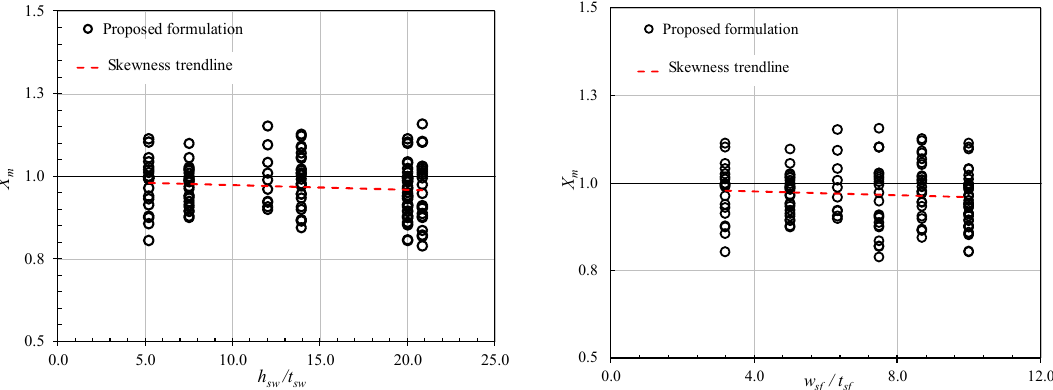
Figure 27. Skewness of the proposed formula against the basic parameters h sw / t sw and w sf / t sf for the stringer-stiffened cylinder.